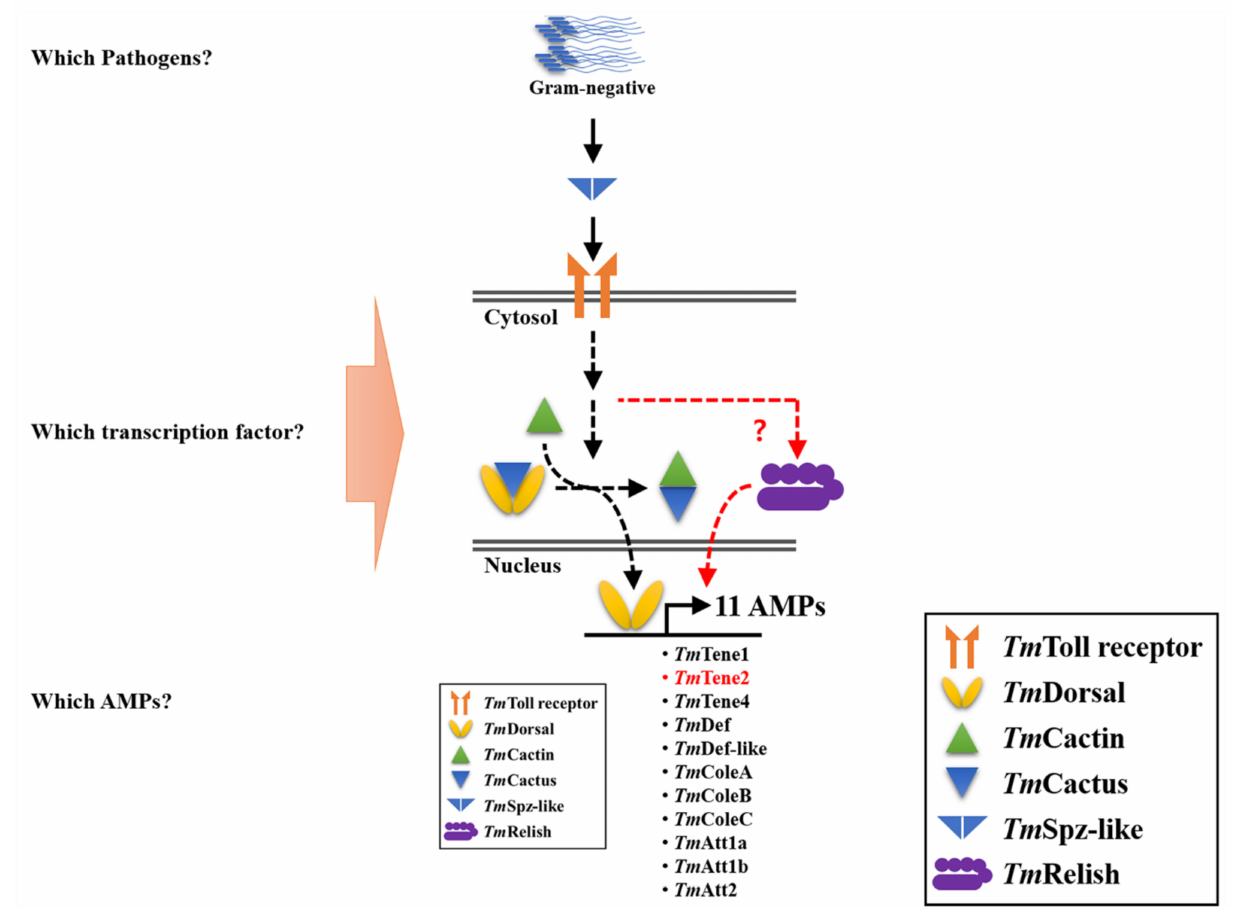
Figure 8. An illustrative summary of the humoral immune pathway positively regulated by TmSpz-like in Escherichia coli -infected Tenebrio molitor. Eleven antimicrobial peptide (AMP)-encoding genes were regulated by TmSpz-like , which indicated that TmSpz-like is required for the survival of the E. coli -infected